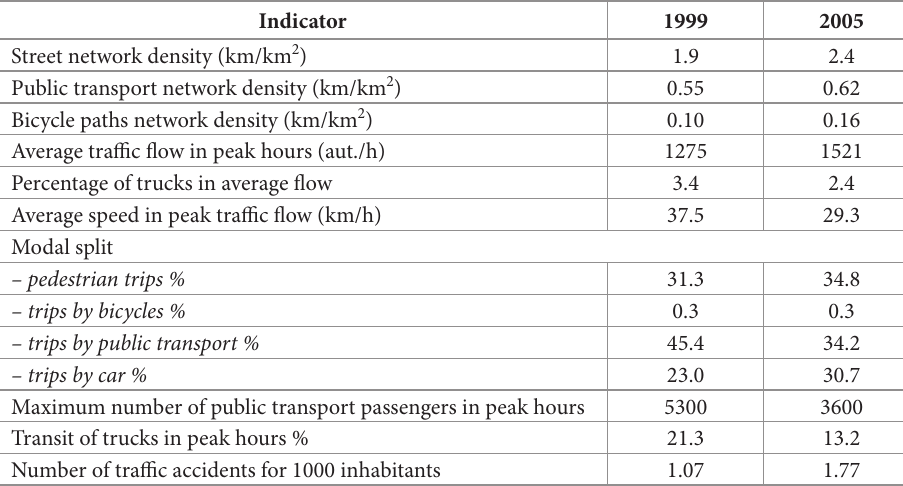
table 1. Transport system indicators in Vilnius city, 1999, 2005